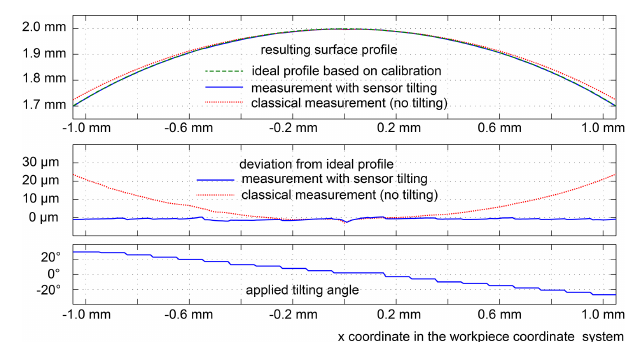
Figure 9. Measurement results with and without sensor tilting on a 4mm